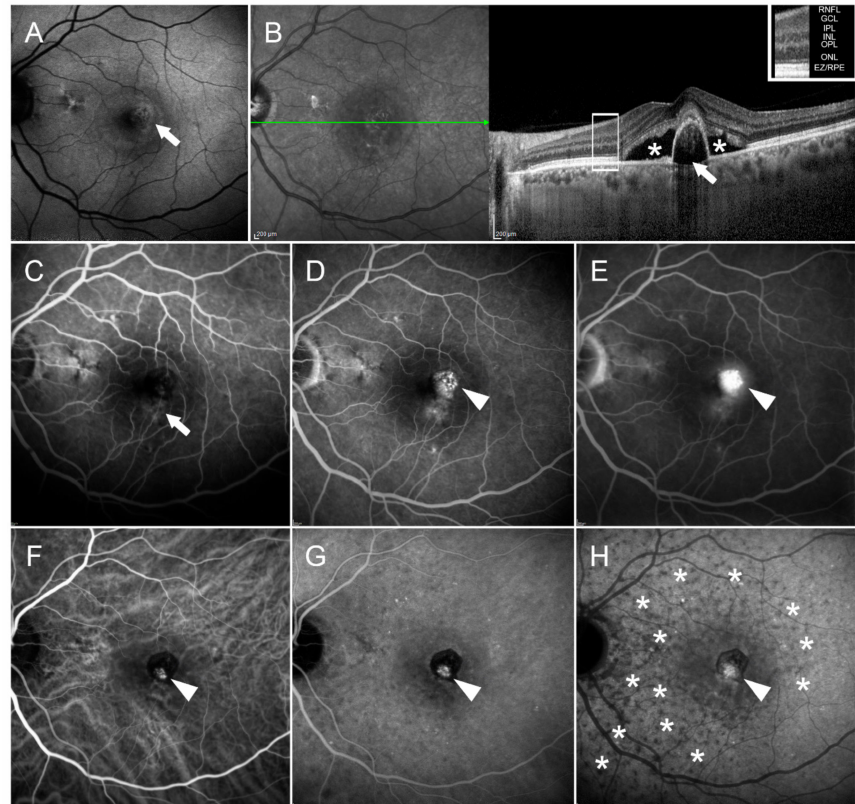
Figure 3. Polypoidal choroidal vasculopathy. BAF ( A ) image shows a mixed autofluorescent macular alteration (white arrow). This corresponds to subretinal fluid (white asterisk) and a PED (white arrow) on structural OCT ( B ). The OCT layers legend is provided in the upper-right part of the images. FA discloses focal RPE atrophy with window defects (white arrow) on early phase ( C ) and a hyperfluorescent lesion in the intermediate and late phases (white arrowheads) (( D , E ), respectively), characterized by leakage and staining phenomena. On ICGA, in the context of sparse choroidal vascular alterations, a branching hypercyanescent network is visible on early phase (white arrow- head) ( F ), becoming more definite in the intermediate and late phases (white arrowheads) (( G , H ), respectively, together with sparse hypocyanescent alterations over the entire posterior pole (white asterisks). The following abbreviations are used: retinal nerve fiber layer (RNFL), ganglion cell layer (GCL), inner plexiform layer (IPL), inner nuclear layer (INL), outer plexiform layer (OPL), outer nuclear layer (ONL), ellipsoid zone/retinal pigment epithelium complex